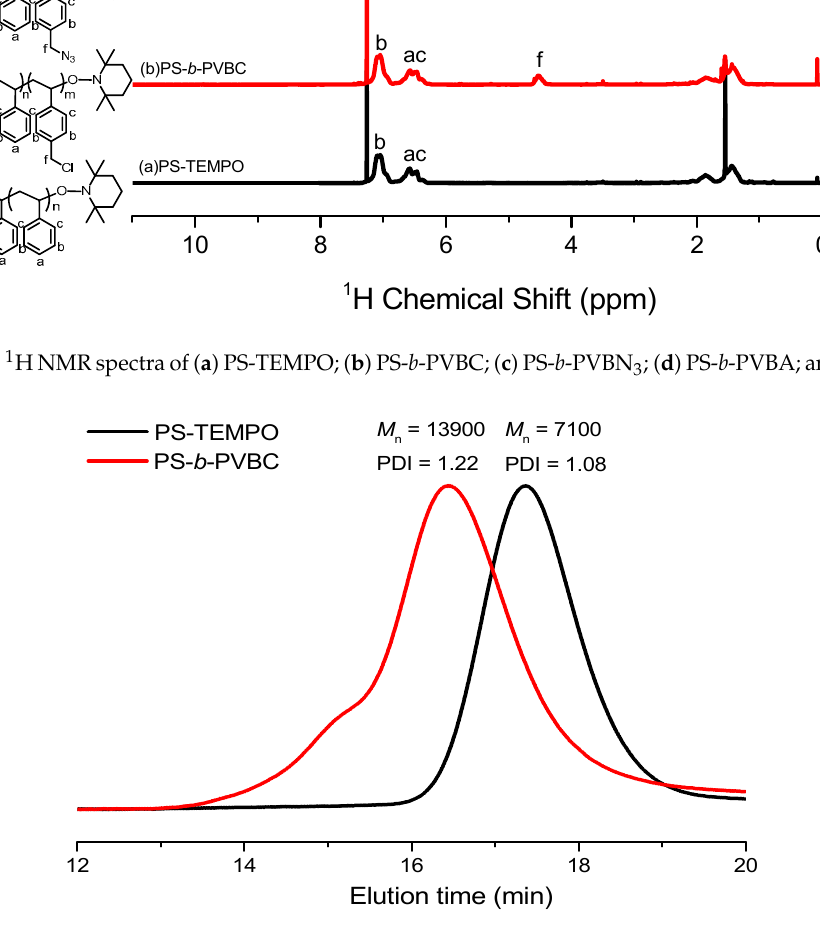
Figure 2. GPC analyses of PS-TEMPO and the PS- b -PVBC diblock copolymer.